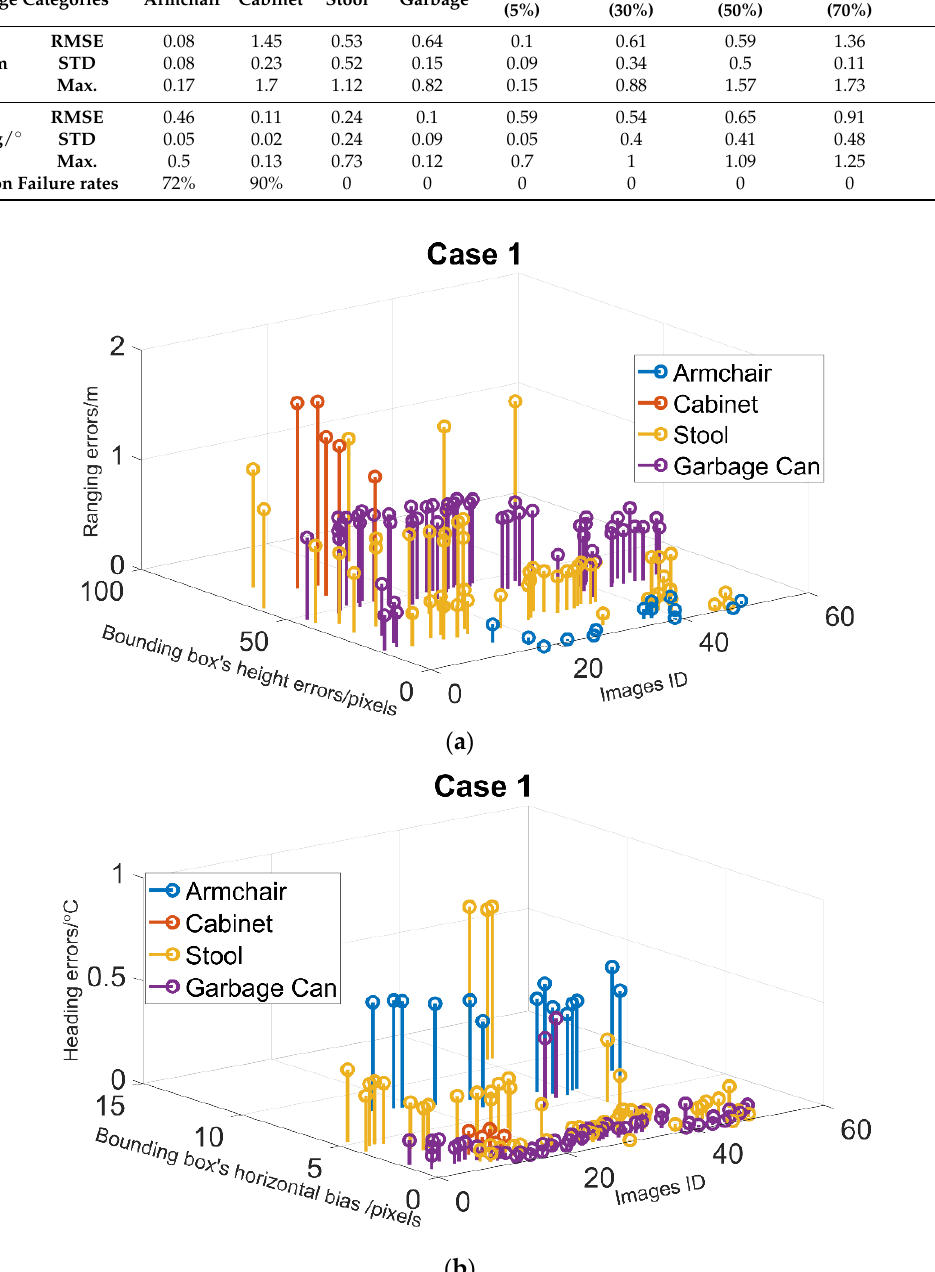
Figure 10. The effect of obstruction by various stationary obstacles. ( a ) Ranging error; ( b ) angulation error.